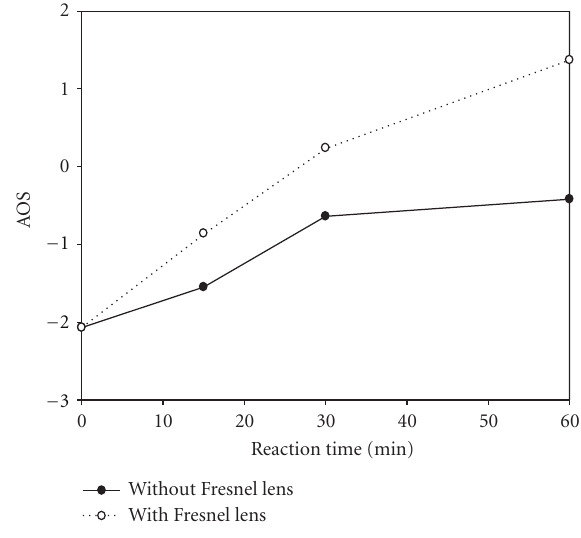
Figure 3: E ff ect of Fresnel lens on AOS of color filter wastewater in solar photo-Fenton process (initial pH: 5.0; H 2 O 2 /COD = 1.25 g/g; [H 2 O 2 ] 0 /[Fe 2+ ] 0 =